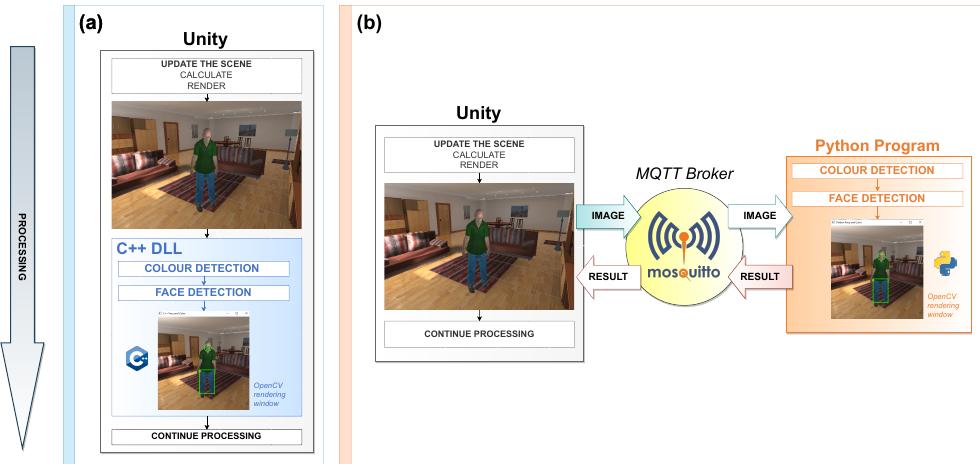
Figure 10. Sequential execution of colour and face detection algorithms: ( a ) C++ DLL, ( b ) Python program communicated via